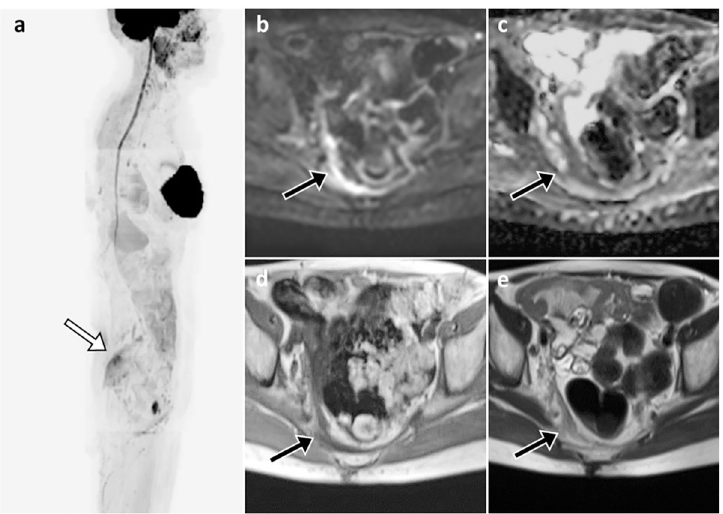
Fig 6. In the same patient of Fig 5, the paired WB-MRI showed thickening of the peritoneum in the right pelvis, which was hyper-intense in DWI b-900 sagittal MIP (a) and DWI axial b-900 images (arrow in b), with corresponding reduced ADC values (c). Axial T1 and T2 images confirmed the presence of a suspicious thickening of the right pelvic peritoneum and mesorectal fascia (arrows in d and e). No significant fluid collection can be seen. Other benign high signal intensity areas in the MIP image (a) include salivary glands, spinal cord, silicon breast implant, spleen, kidneys, small bowel and a bartholin’s gland cyst. The PD reported at WB-MRI determined a change in treatment from Letrozole to